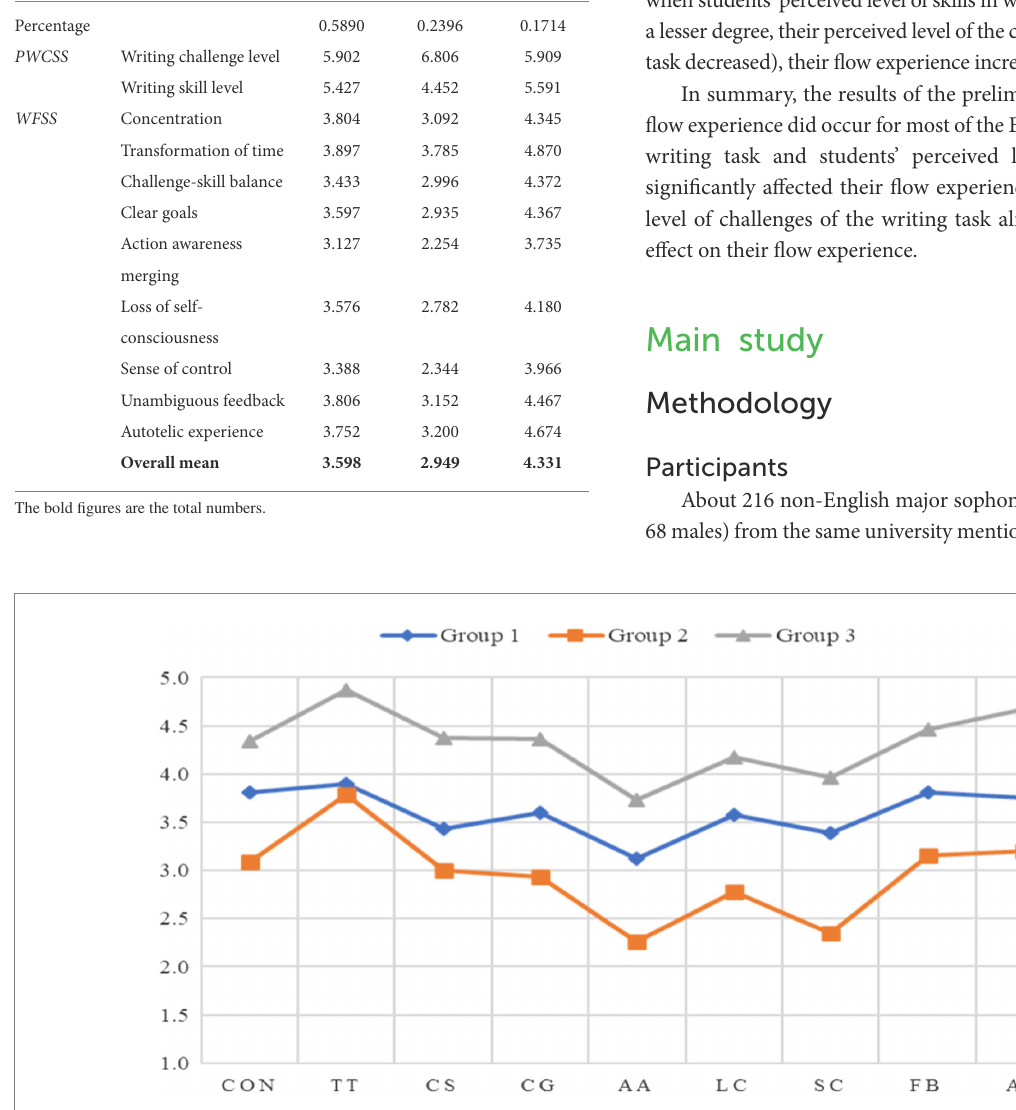
FIGURE 1 Profile plot of the Three-Group LCFA Model of WFSS . CON, concentration on the task at hand; TT, transformation of time; CS, challenge-skill balance; CG, clear goals; AA, action-awareness merging; LC, loss of self-consciousness; SC, sense of control; FB, unambiguous feedback; and AE, autotelic experience. The y -axis listed item-average scores and the x -axis presented flow